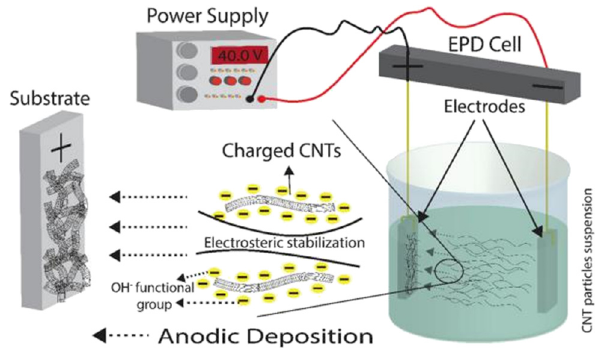
Figure 9: Schematic illustration of the anodic EPD process of CNTs [ 49 ] .